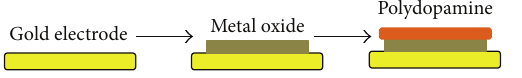
Figure 2: (a) Precursor; (b) manganese oxide.